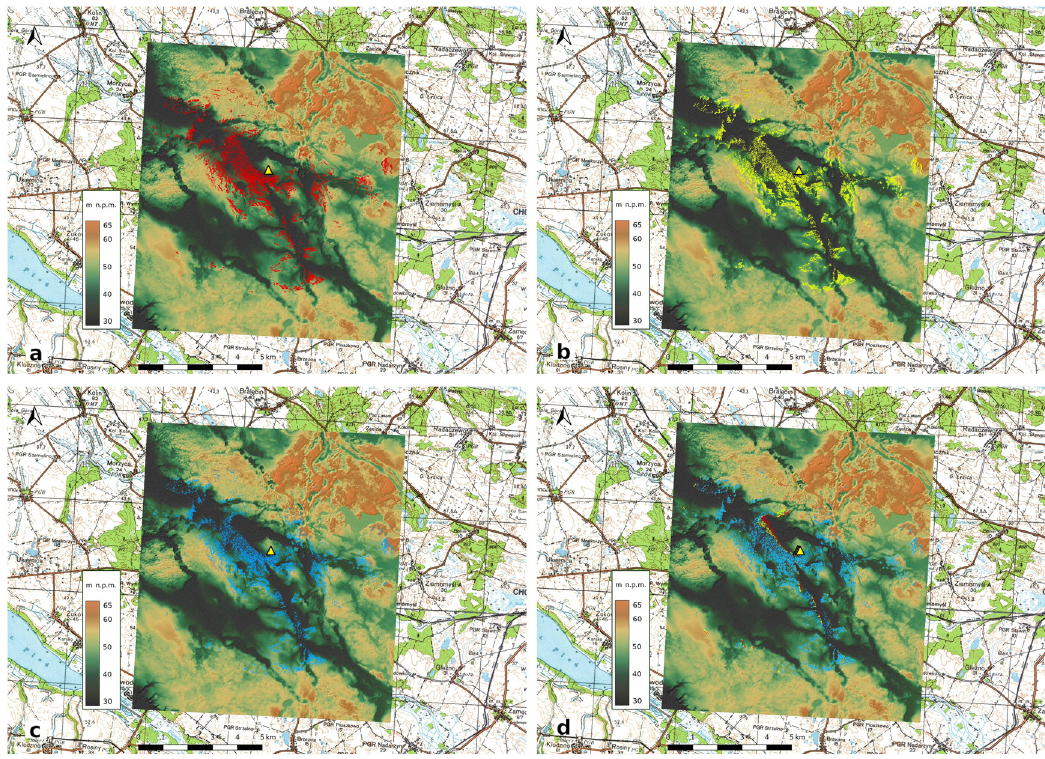
Figure 12: The Dolice - Komorowo North megalithic group. The area visible from the tombs 6 ( a ) , 7 ( b ) , 8 ( c ) and the juxtaposed views ( d ) ( M. Schiller )